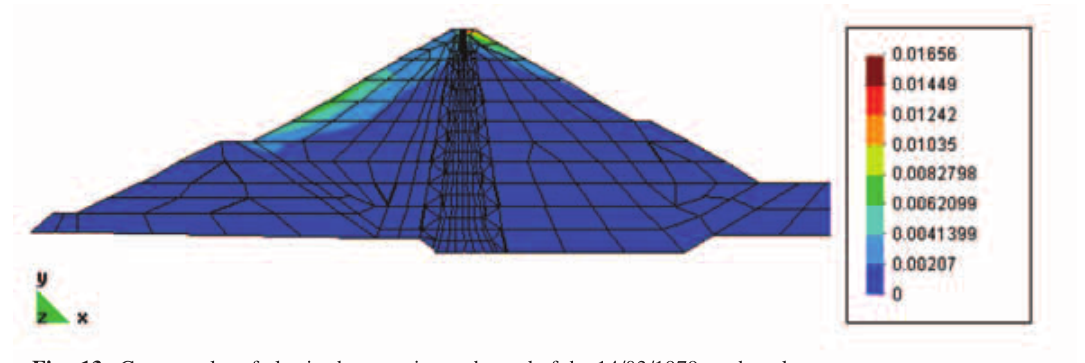
Fig. 13. Contour plot of plastic shear strains at the end of the 14/03/1979 earthquake.